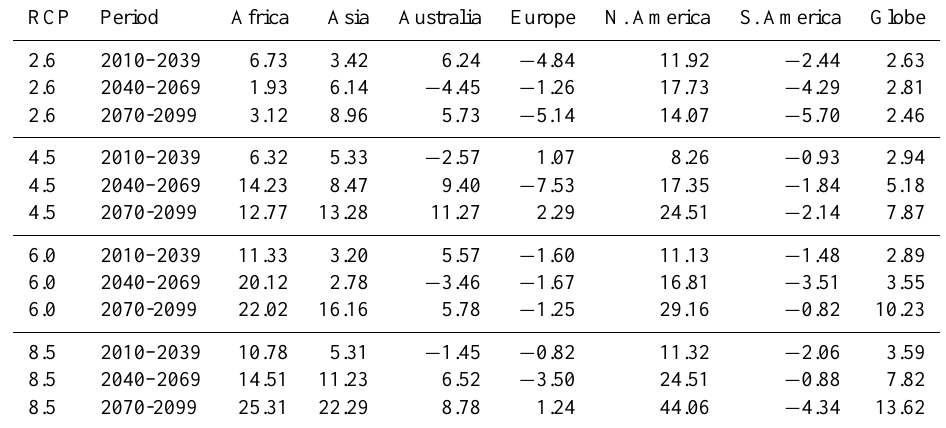
Table 2. 15) Percentage change in continental river discharge simulated by HadGEM2-ES for 30-year means relative to 1970–2000 for the 4 RCP scenarios.